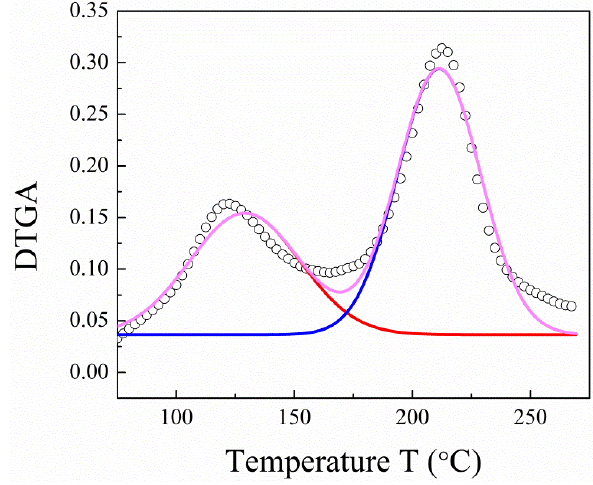
Figure 14: DTGA curve for PVA/PANi/Fe 3 O 4 blend nanocomposite loaded with 10 wt.% of Fe 3 O 4 sample, fitting curve (pink), and peak separation (red and